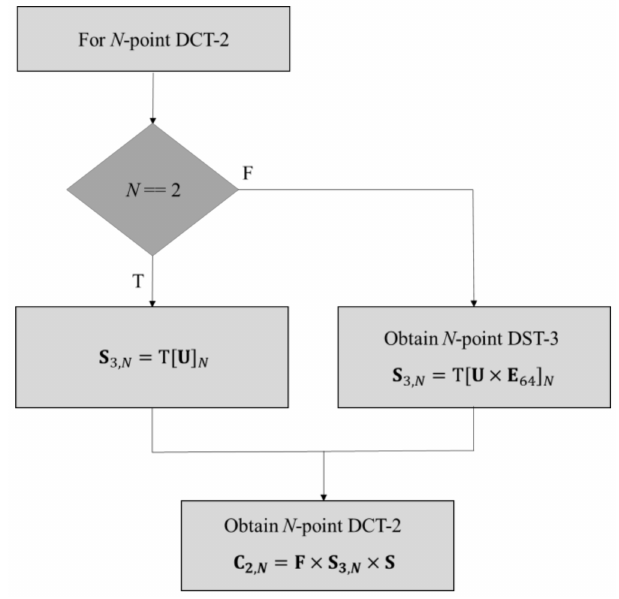
Figure 5. Illustration of the proposed DCT-2 transform